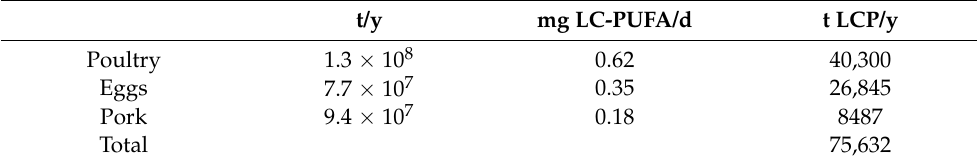
Table 2. Estimated global availability of n-3 LC-PUFA from terrestrial sources [110,111]).